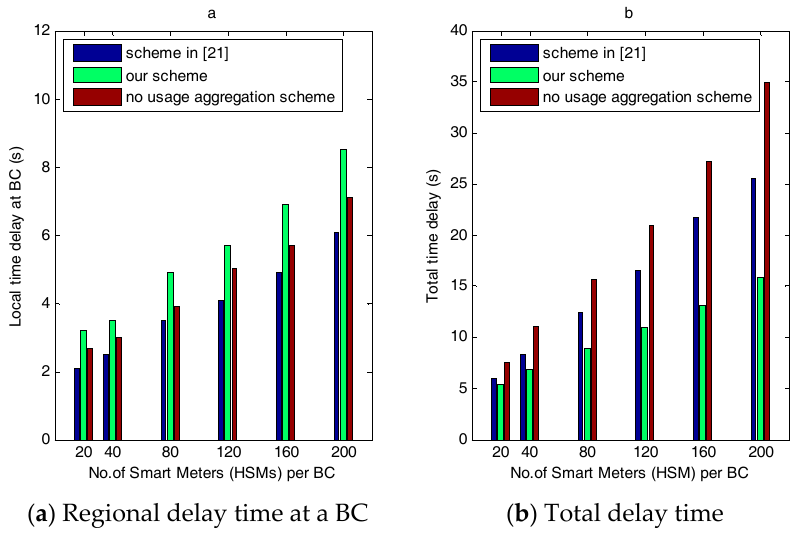
Figure 7. The computation time delay for our scheme, the scheme in [21] and the no-consumption aggregation scheme in the power requirement stage.